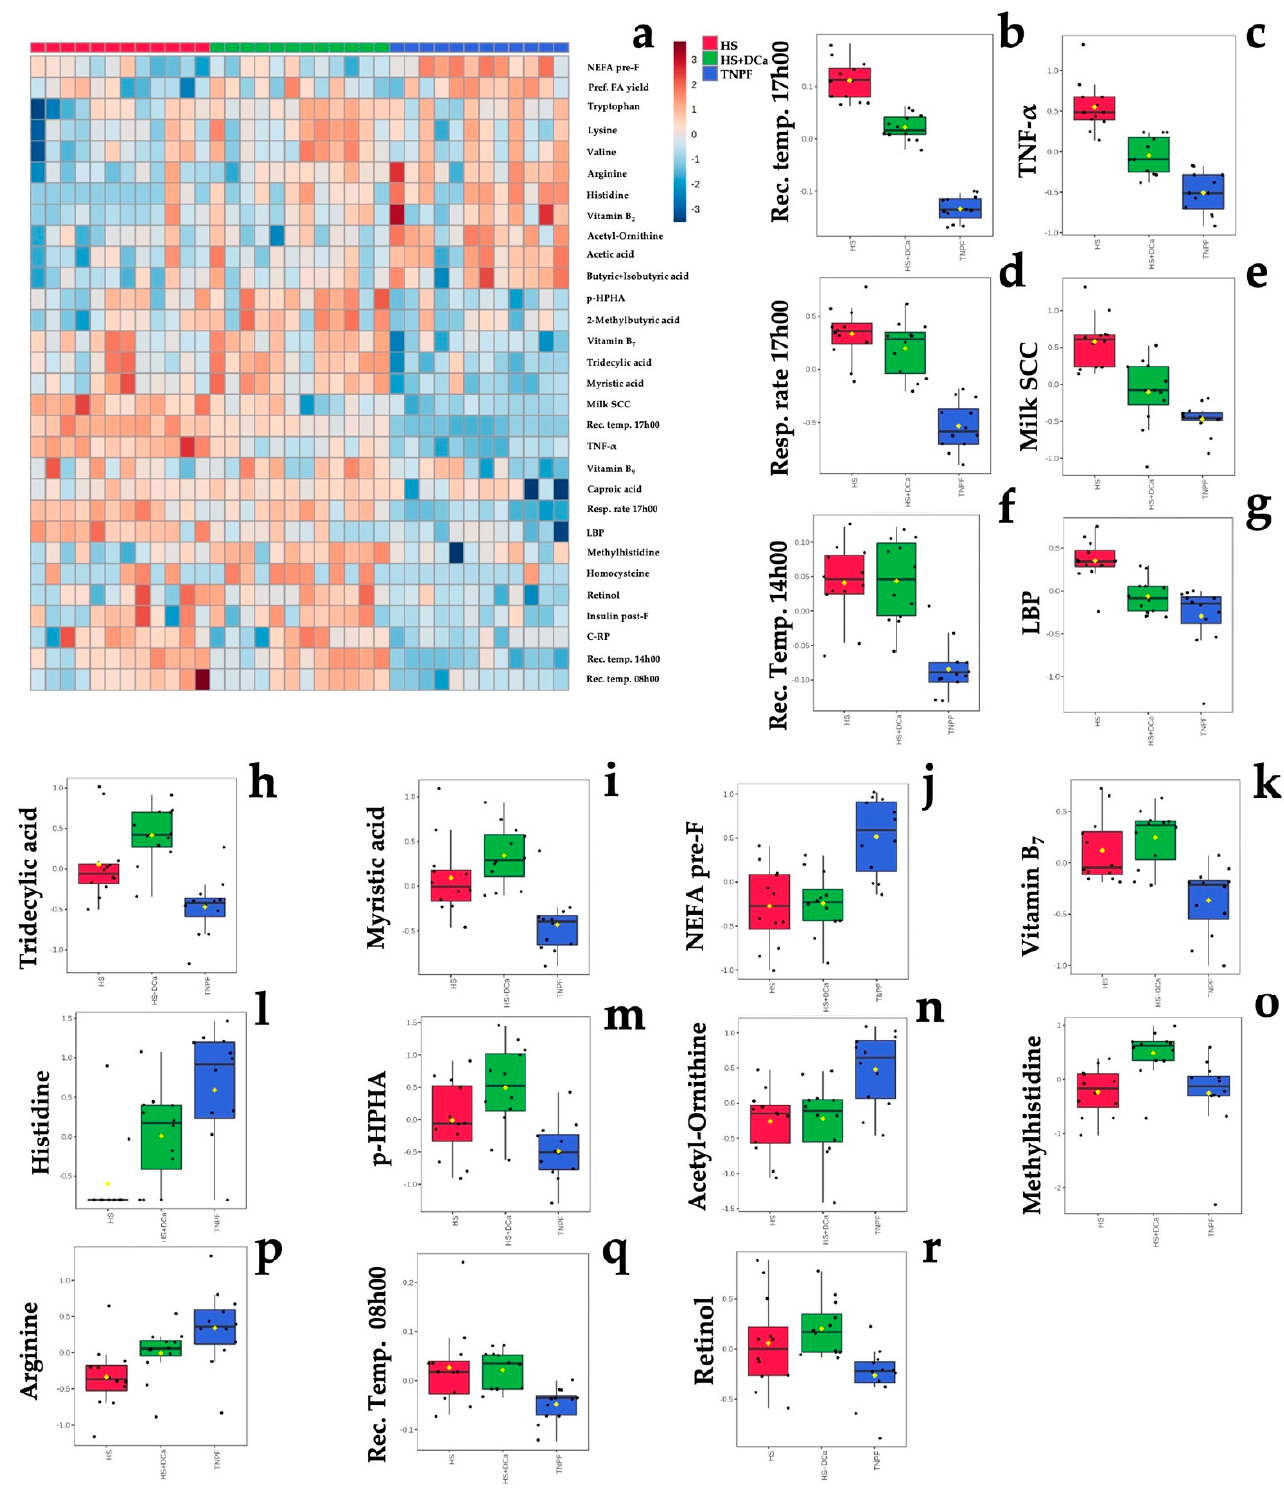
Figure 2. Differences in fecal metabolites of dairy cows following heat stress, heat stress with vitamin D 3 and Ca, or pair feeding in thermoneutrality. ( a ) Heat map of the top 30 fecal metabolites influenced by treatment. ( b – r ) Treatment differences in rectal temperature at 08h00, 14h00, and 17h00 (rec. temp.), respiratory rate at 17h00 (resp. rate 17h00), milk somatic cells (milk SCC), plasma tumor necrosis factor–alpha (TNF- α ), lipopolysacaride-binding protein (LBP), tridecylic acid, myristic acid, non-esterified fatty acids prior to feeding (NEFA pre-F), vitamin B 7 , histidine, p-hydroxyphenilacetic acid (p-HPHA), acetyl-ornitine, methylhistidine, arginine, and retinol identified in ANOVA with the false discovery rate (FDR) method. Normalized, pareto-scaled concentration